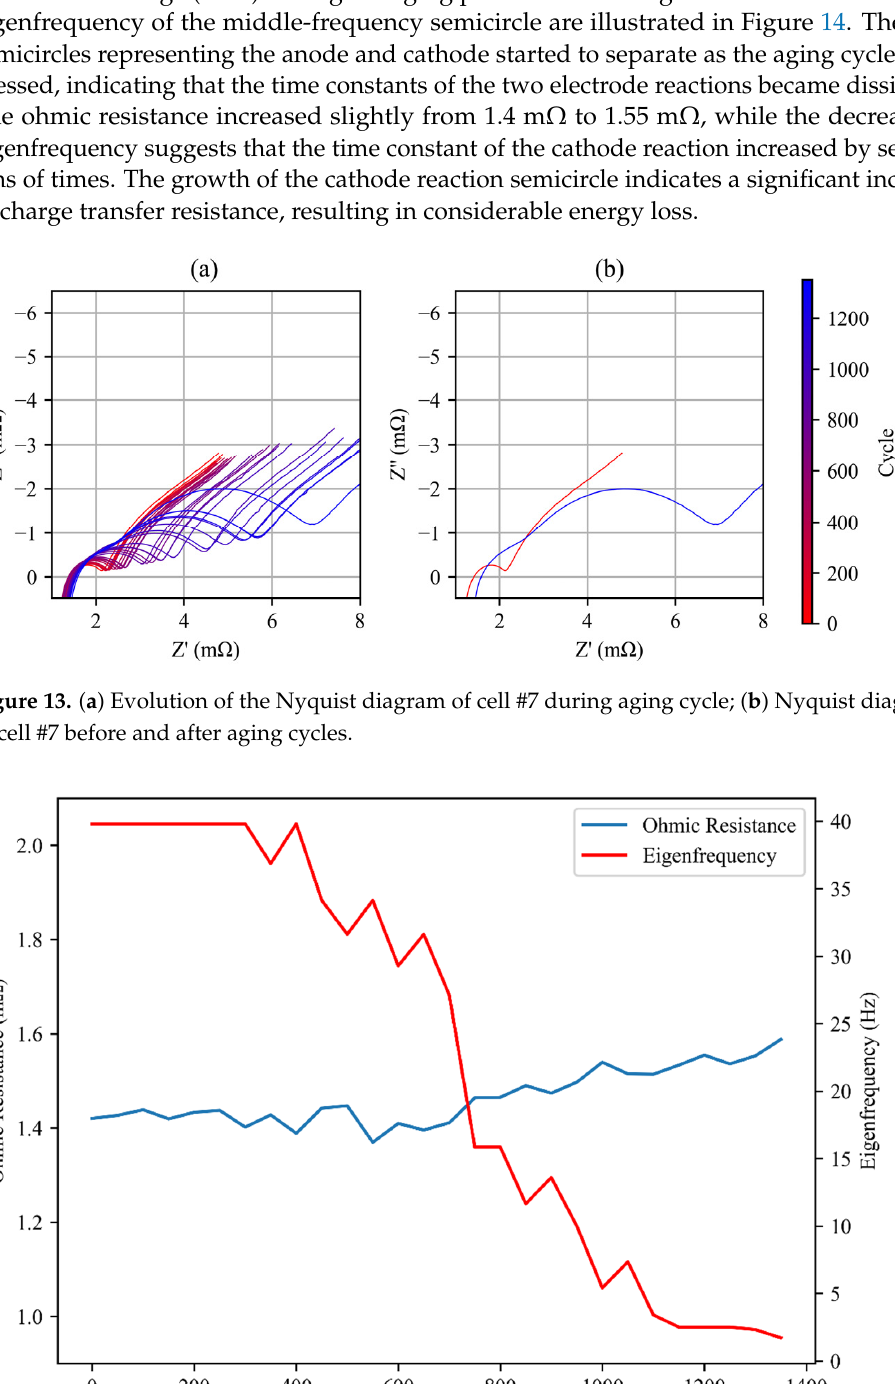
Figure 12. Typical Nyquist diagram of LTO/LMO cell at room temperature.